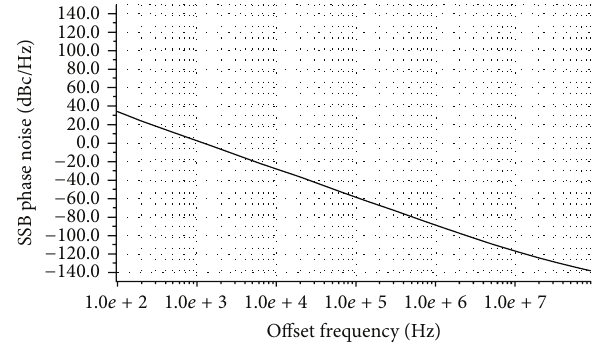
Figure 7: Single side-band (SSB) phase noise (PN) of the proposed ring-VCO.